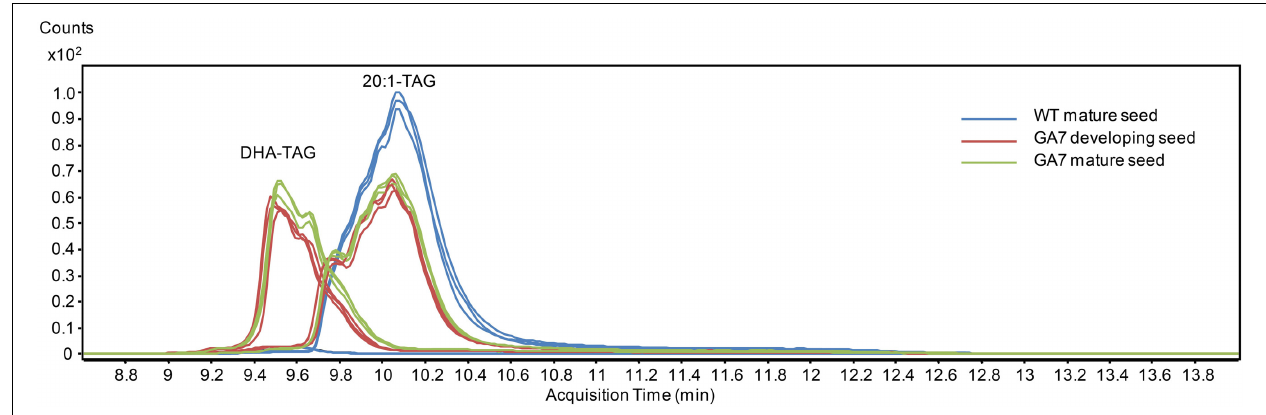
FIGURE 7 | Total ion chromatogram from multiple reaction monitoring (MRM) of the triacylglycerol (TAG) species containing 20:1 or DHA from the WT and the GA7 Arabidopsis seeds.